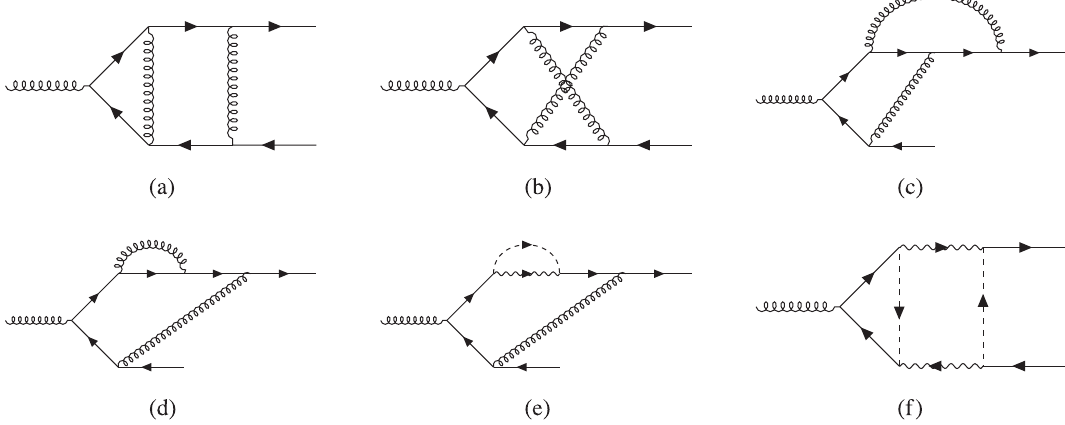
FIG. 13. Two-loop diagrams for vertex corrections to γ 0 . In these diagrams, the solid line is for the f propagator, the dashed line is for the ψ propagator, the wavy line is for the b propagator, and the spiral is for the ϕ